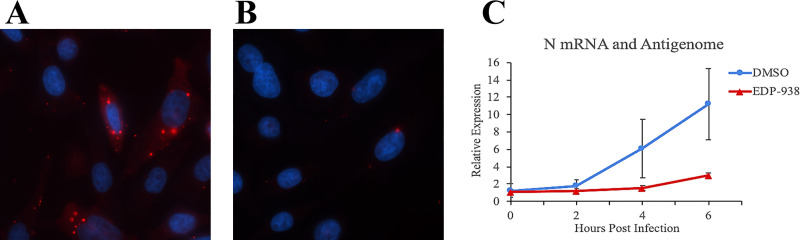
EDP-938 prevents primary transcription of RSV mRNAs.Following a synchronized infection with RSV-A2 (MOI of 3), DMSO or 1000 nM EDP-938 was added at 0 hpi. Immunofluorescence analysis of inclusion bodies at 8 hpi in the presence of DMSO (A) or EDP-938 (B). N protein was detected with an N specific monoclonal antibody (red) and cell nuclei were stained with DAPI (blue). (C) RT-qPCR analysis of RSV N gene expression between 0 and 6 hpi. Samples were quantified using the ΔΔCt method relative to the mean expression of housekeeping gene GAPDH. The relative expression of positive sensitive RNA is shown. Data are representative of two independent experiments.